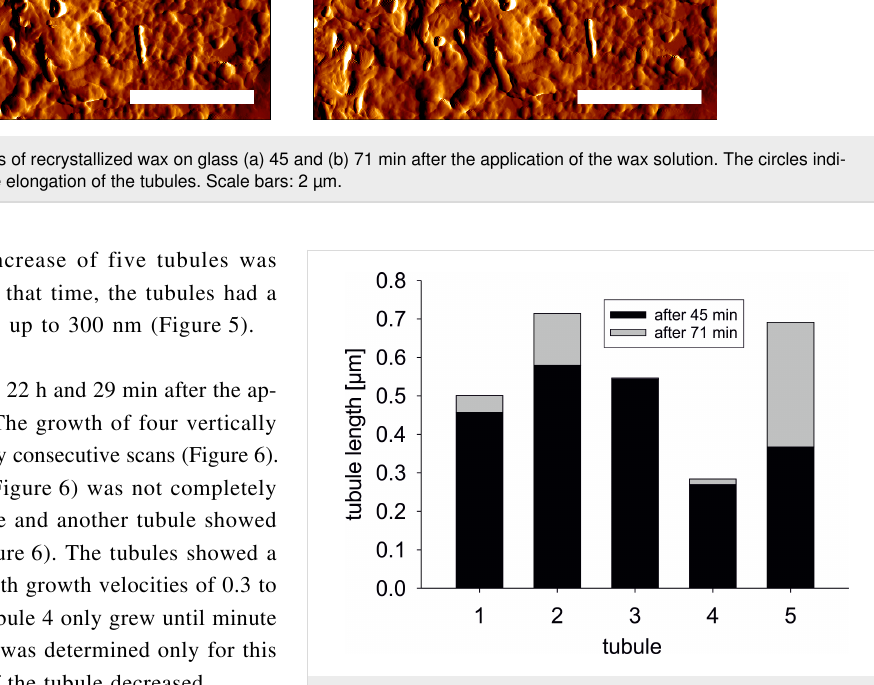
Figure 5: Diagram of length increase of recrystallized tubules (1–5) from a wax solution on glass within 26 min. The measurements of length increase were performed 45 and 71 min after the application of the wax solution on the